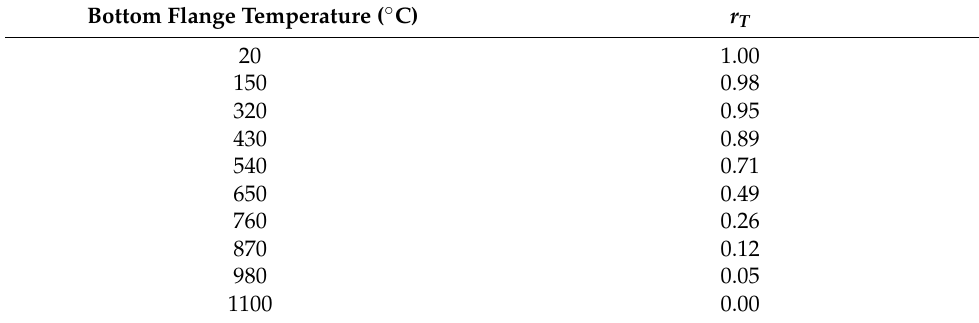
Table 1. Retention factor